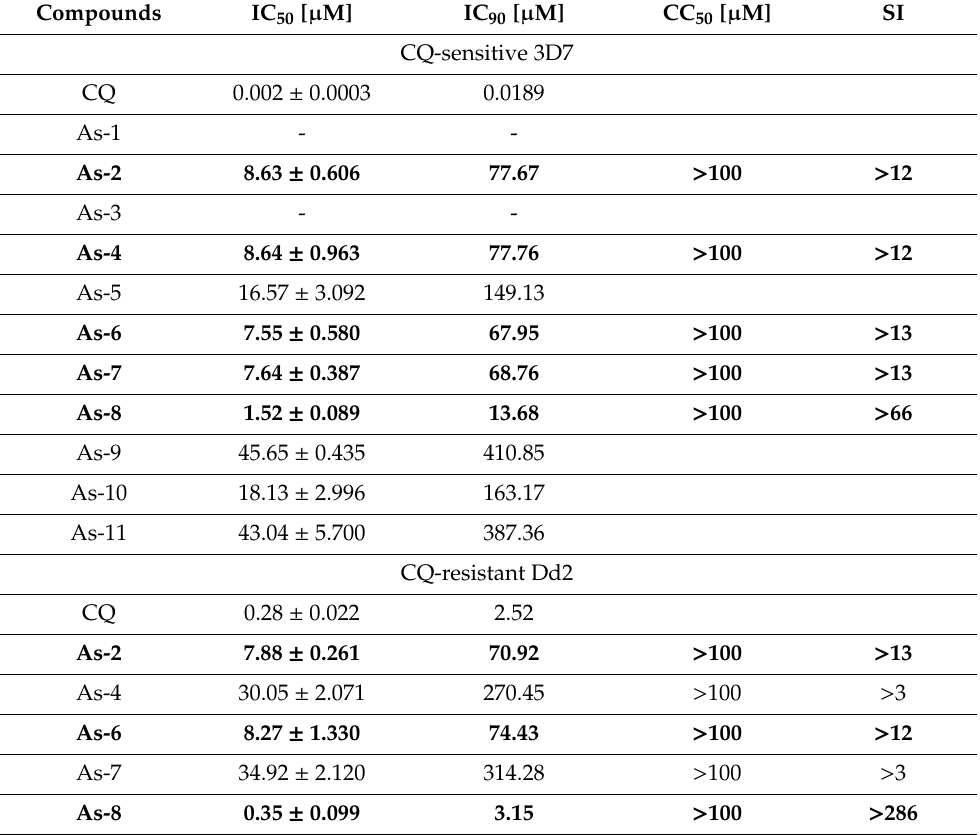
Table 1. Antiplasmodial activity of organoarsenic compounds against the CQ- sensitive 3D7 and CQ-resistant Dd2 strains of P. falciparum